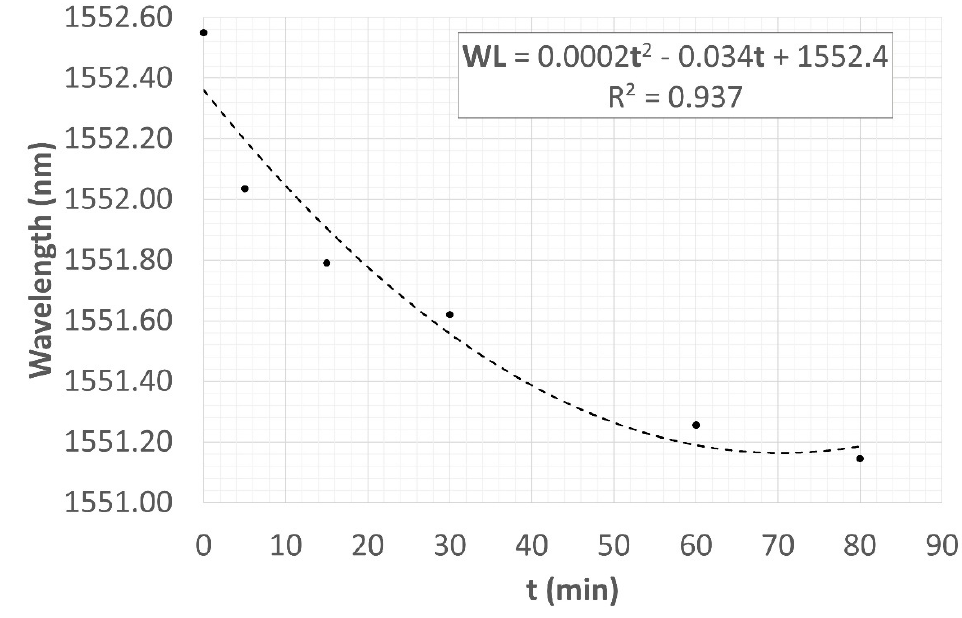
Figure 15. CWL stabilization